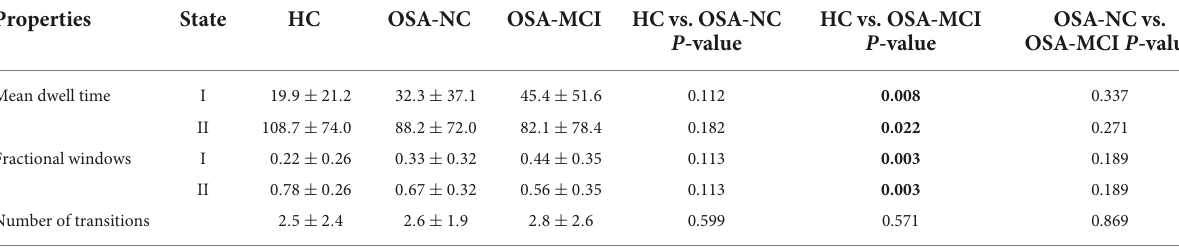
TABLE 2 The dynamic FNC temporal properties between OSA patients and HC groups.